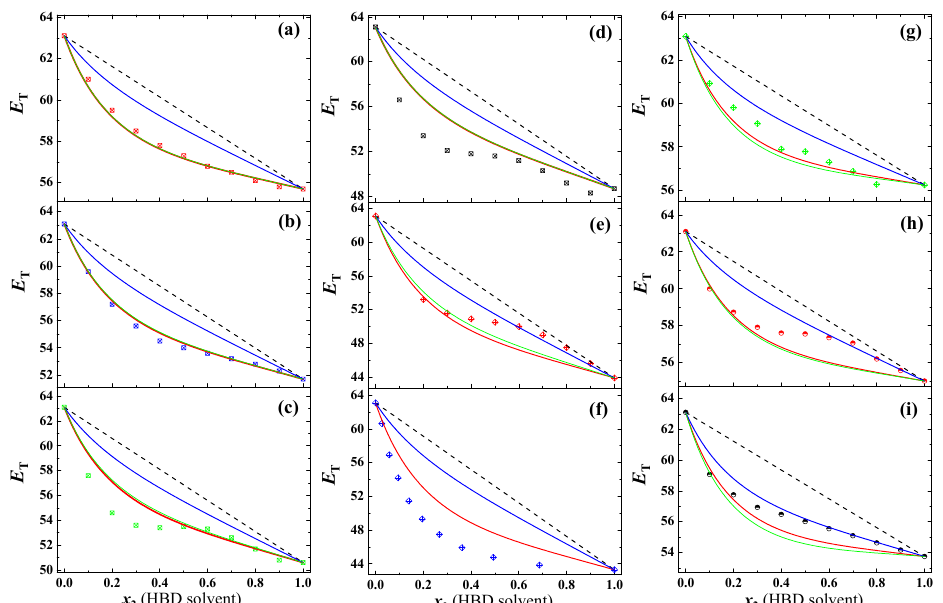
Figure 6. Electronic transition of ( E T (30), kcal · mol − 1 ) of nine aqueous mixtures of water (1)—hydrogen bond donor (HBD, 2) as a function of mole composition of component 2 ( x 2 ) at 25 °C. Symbols ( a – i ) and reference sources are given in Table 2 (entries 10–18). Black dashed lines show calculations from the ideal model (Equation (1)). Blue solid lines show predictions with the predictive model (Equation (2)) without considering HBD contribution factor ( CF HBD = 1). Red solid lines show prediction with the predictive model (Equation (2)) with considering actual CF HBD values in Table 1. Green solid lines show prediction with the predictive model (Equation (2)) with considering calculated CF HBD values using Equation (7). Appl. Sci. 2020 , 10 , x FOR PEER REVIEW